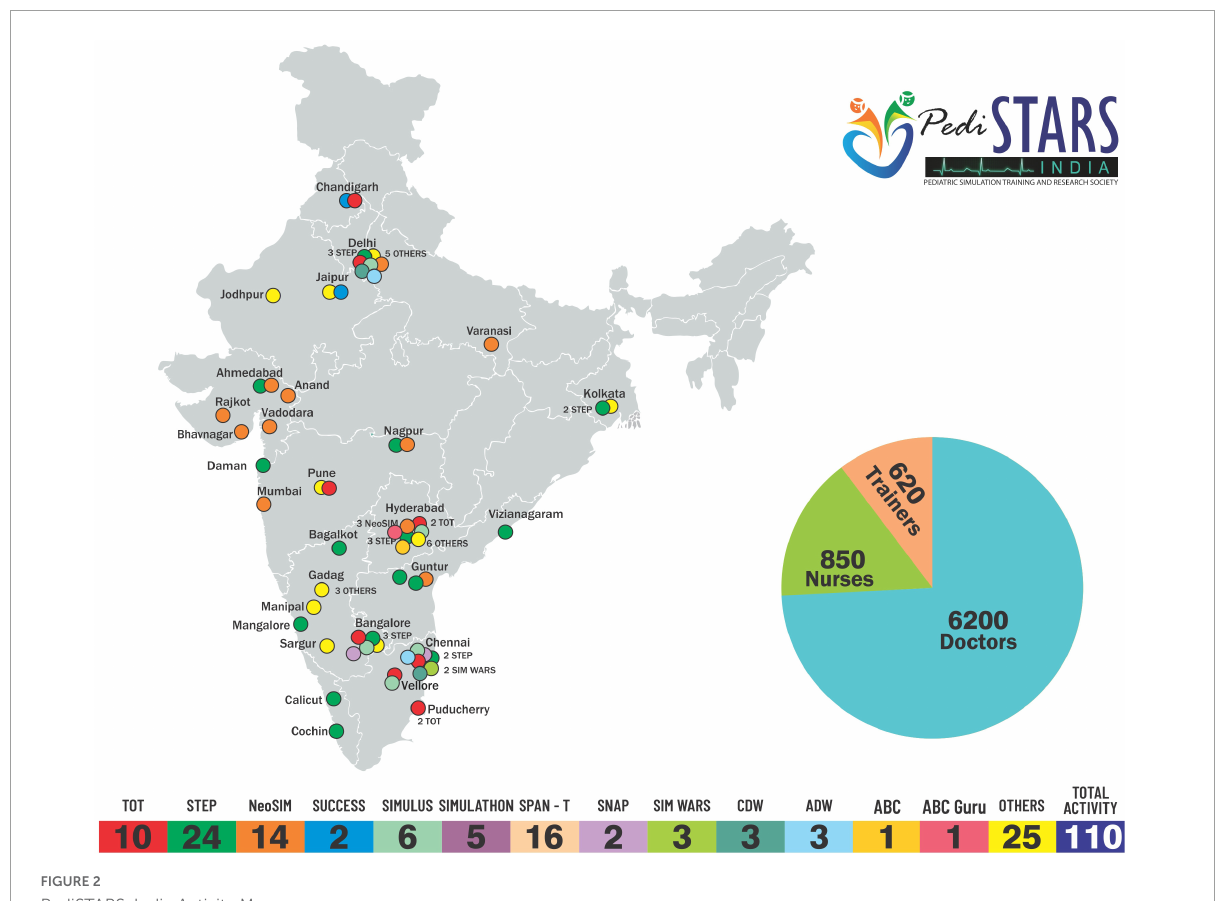
FIGURE2 PediSTARS, India Activity